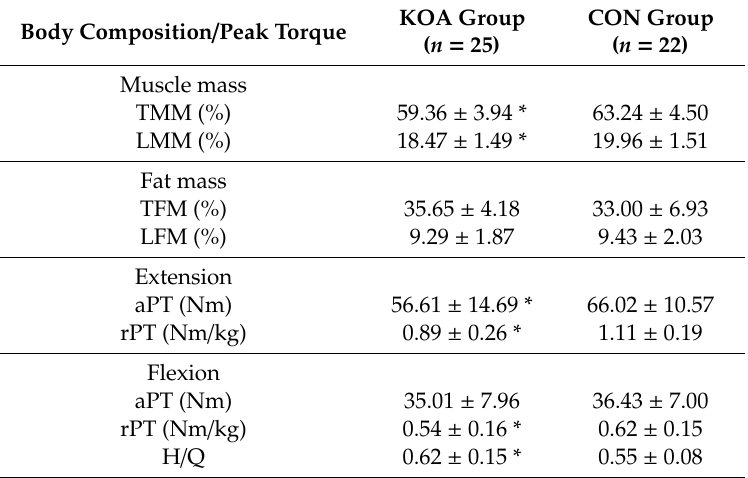
Figure 2. ( a ) Comparison of the muscle mass (total muscle mass (TMM) and lower limbs muscle mass (LMM)) between the KOA and control group (CON) groups; ( b ) comparison of the absolute peak torque (aPT) of the knee joint between the KOA and CON groups; ( c ) comparison of the relative peak torque (rPT) of the knee joint between the KOA and CON groups; and ( d ) comparison of the relative peak torque ratio (H / Q) of knee flexion and extension between the KOA and CON groups. * means p < 0.05. Table 3. Comparison of knee joint peak torque and body composition of participants between the KOA and CON groups (mean ±